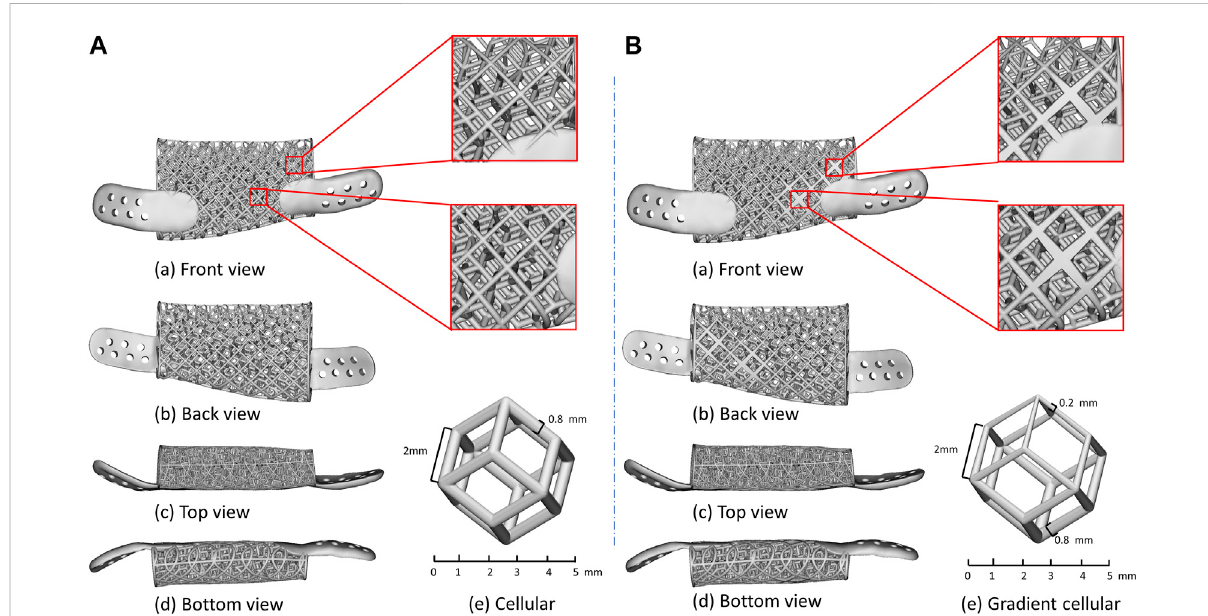
FIGURE 7 Details of lattice-like implant comparison. (A) Original lattice-like implant with a front view (a), back view (b), top view (c), bottom view (d) and regulardodecahedronunitcellular(e); (B) Optimizedlattice-likeimplantwithafrontview(a),backview(b),topview(c),bottomview(d)andgradient cellular